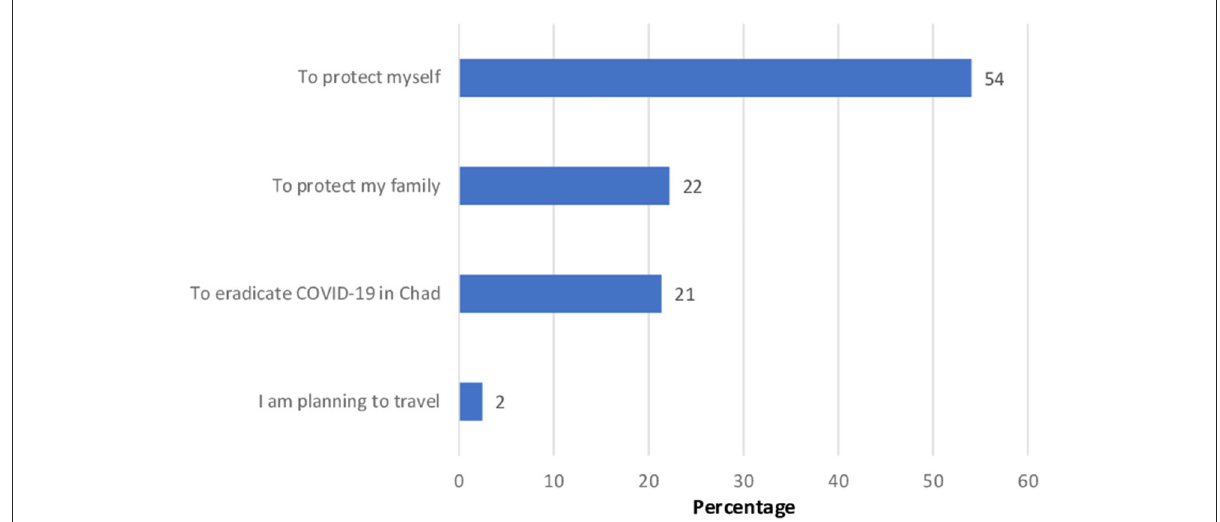
FIGURE1 Listed reasons to be vaccinated against COVID-19, ranked in order of importance (in percent) among participants who are willing to be vaccinated ( n = 2,477).